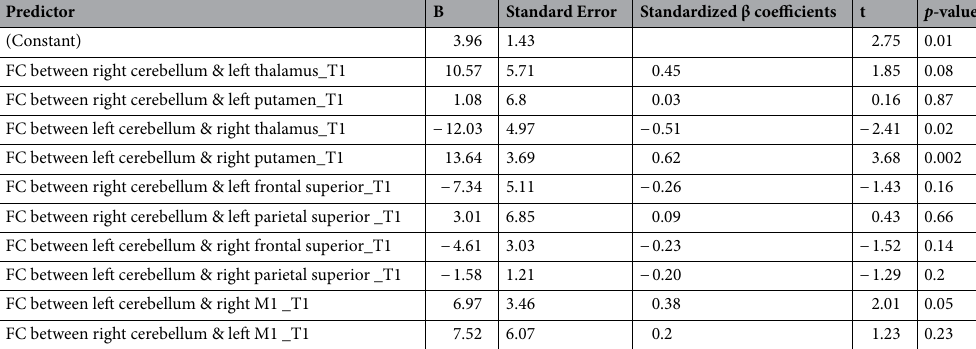
Table 4. Multi-variate regression model of baseline IntraHFC at the cerebellar-cortical and cerebellar- subcortical networks to predict recovery of dynamic balance (ΔCB&M). FC functional connectivity, T1 pre- intervention, M1 motor cortex.